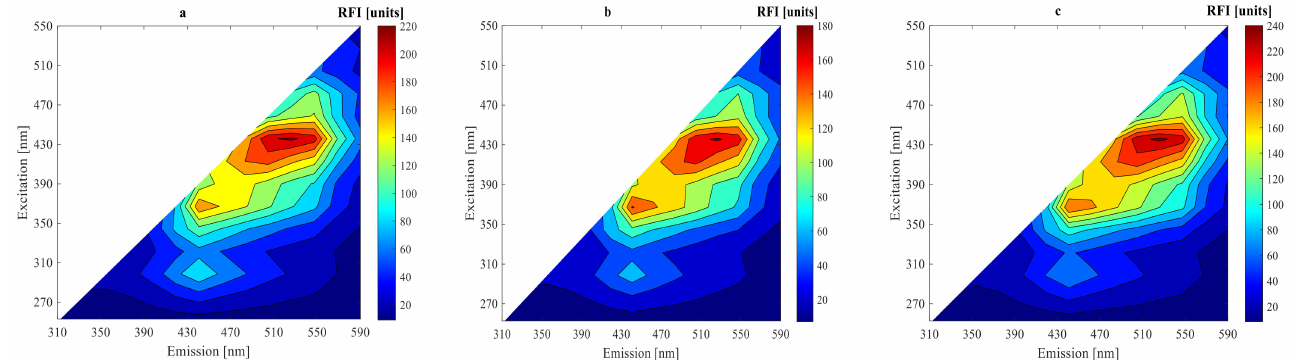
Figure 3. Original spectra after ( a ) 0 h, ( b ) 9 h, and ( c ) 15 h fermentation of 7 g/100 mL substrate inoculated with 6 log cfu/mL mixed strains of Lactiplantibacillus plantarum A6 and Lacticaseibacillus rhamnosus GG.